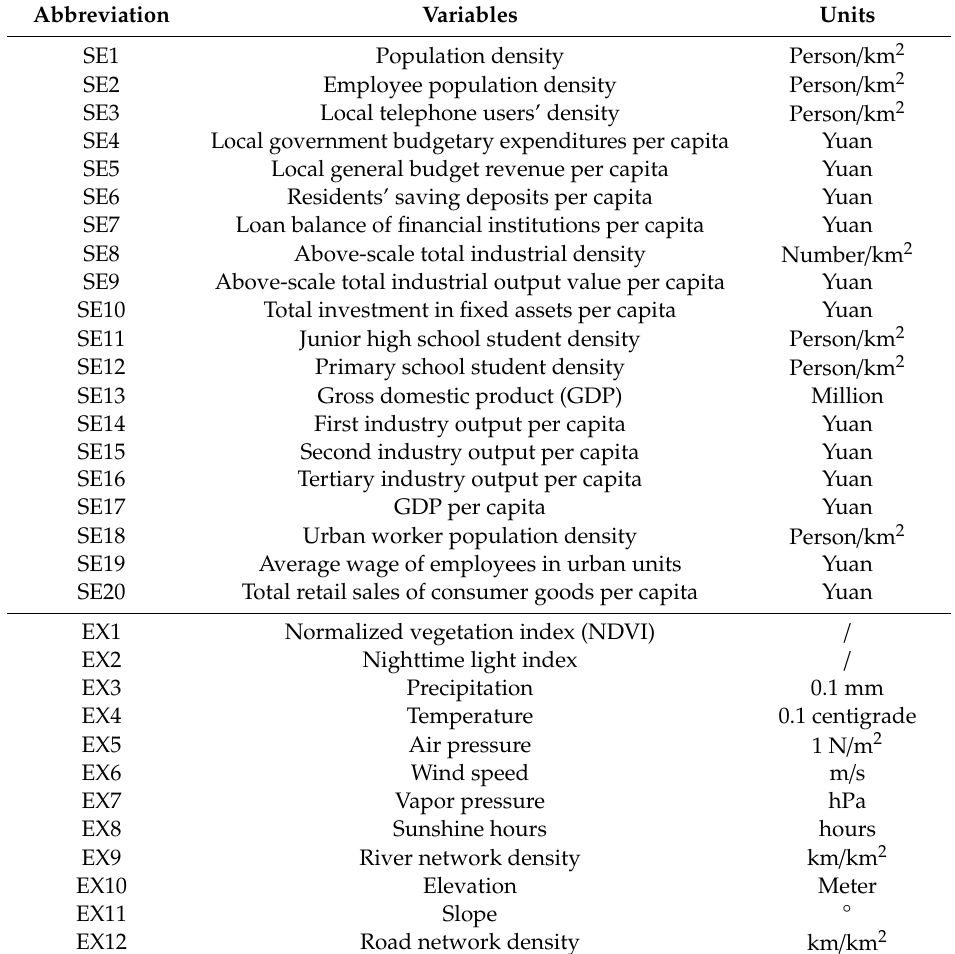
Table 1. Indicator system of socioeconomic and environmental variables potentially a ff ecting county-level hospital bed resources in southwest China (SE1–SE20 denote socioeconomic variables, and EX1–EX12 denote environmental